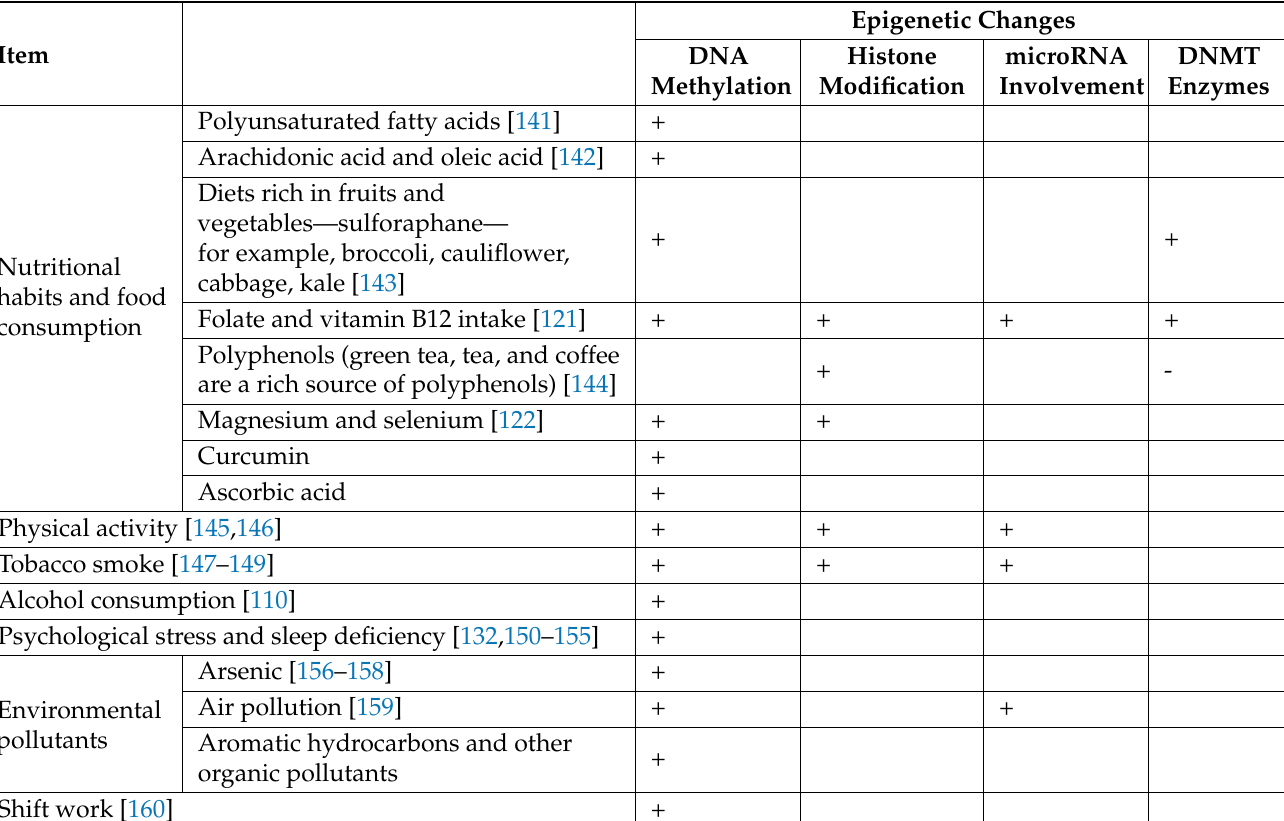
Table 3. Lifestyle and environmental factors and type of epigenetic modification and CVD.